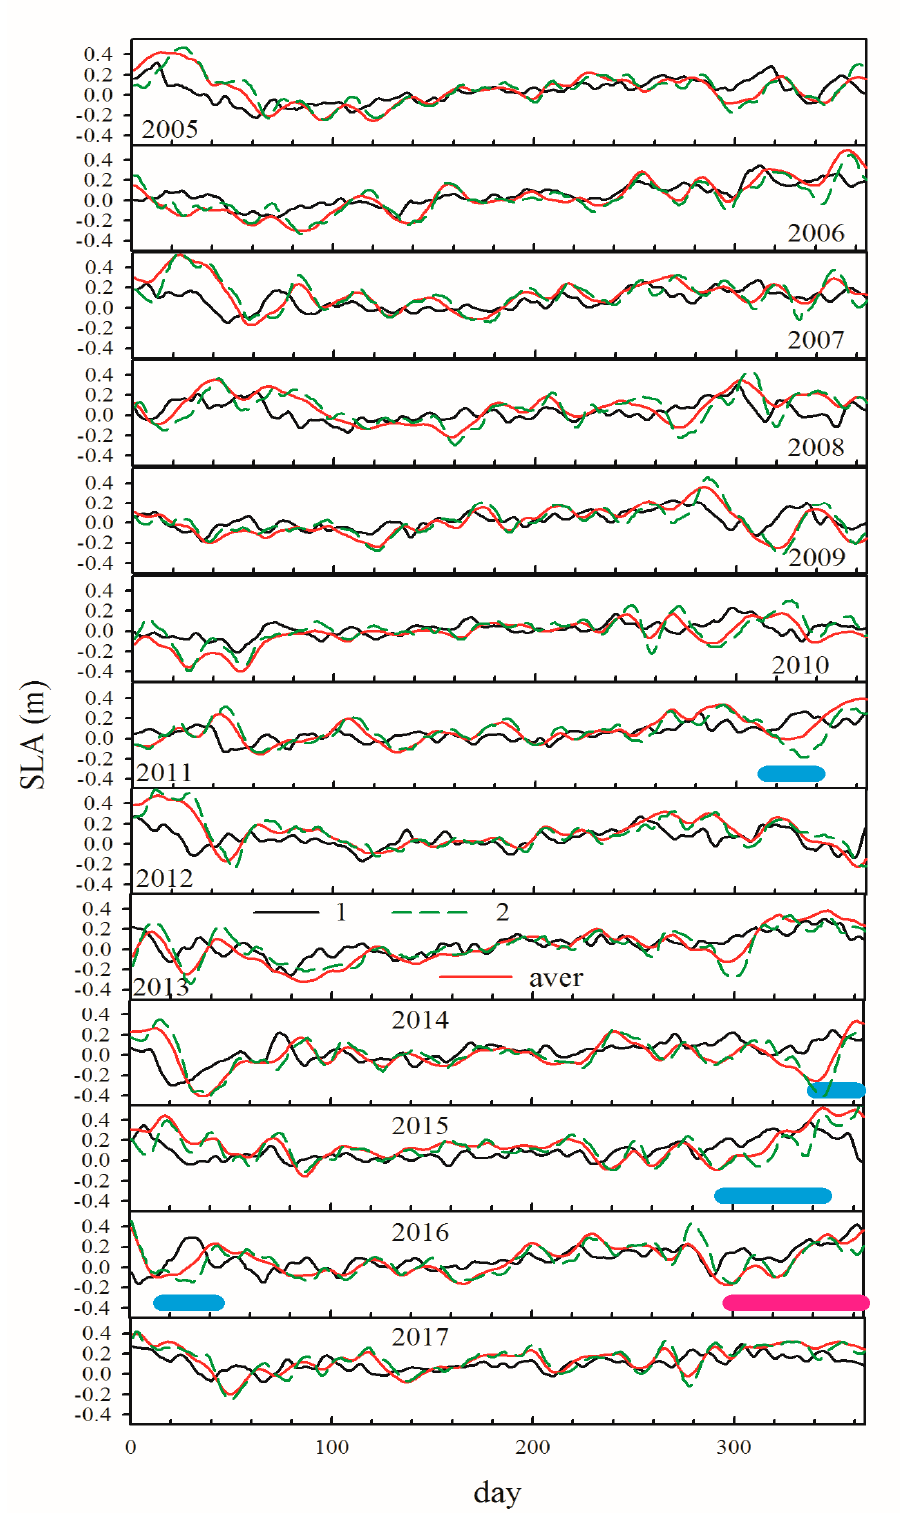
Figure 11. Time series of SLA in years 1993–2017. Data for pixel 1 (North Sea) are shown as a solid black line, for pixel 2 as a dashed green line, and for the mean SLA in the Baltic Sea proper as a red line. Horizontal thick blue lines indicate MBI events. The inflow event during the fall of 2016 has been marked in red, which has not been classified in IOW reports as the